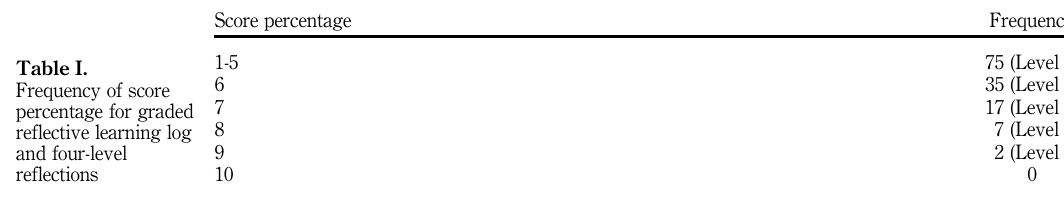
Table I. Frequency of score percentage for graded reflective learning log and four-level